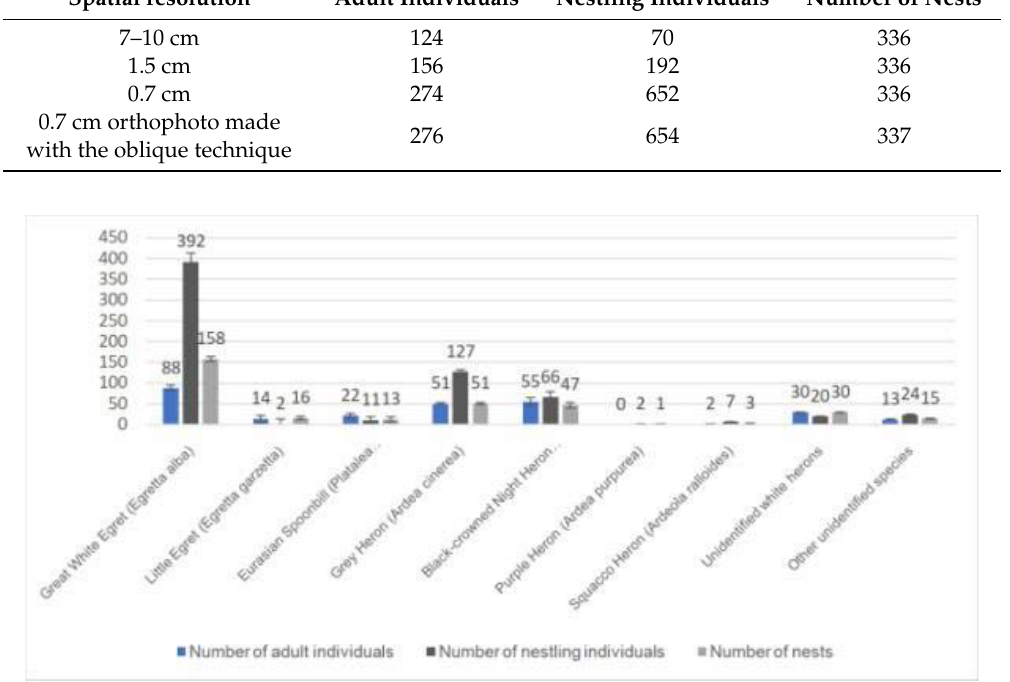
Figure 11. Results with additional oblique photogrammetry at Lake Kolon sample area. The distribution of individuals and nests in the observed area identified in the orthophotos made with the oblique camera technique with 0.7 cm spatial resolution.